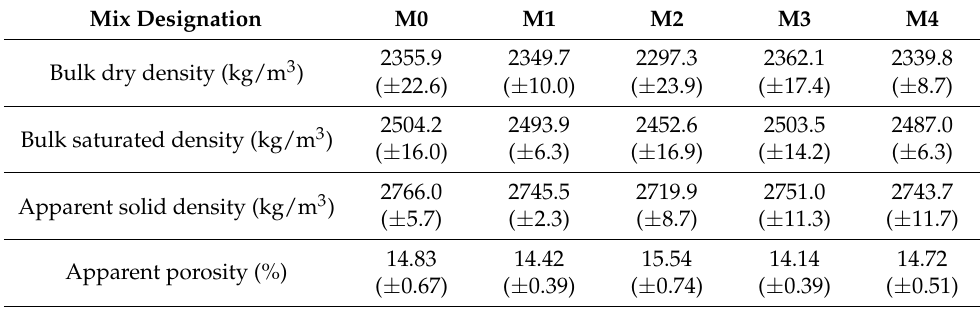
Table 4. Densities and porosity of concrete.